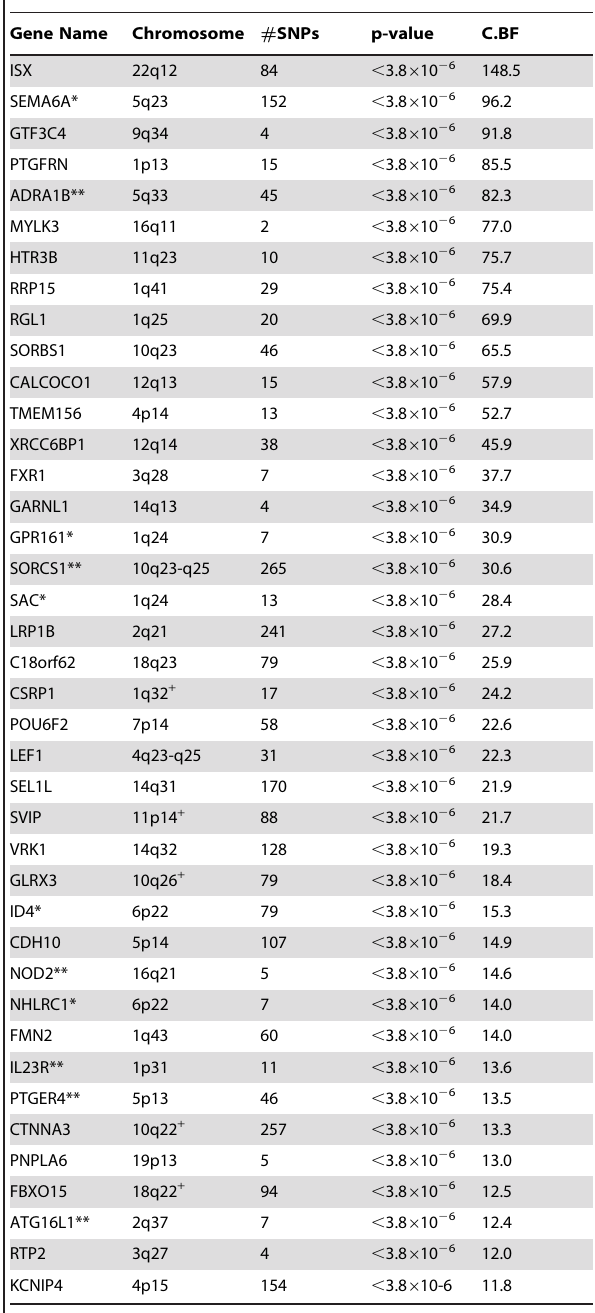
Table 1. Forty genes with the strongest evidence for association with Crohn’s Disease risk, with chromosomal locations, numbers of SNPs, approximate p-values, and Bayes